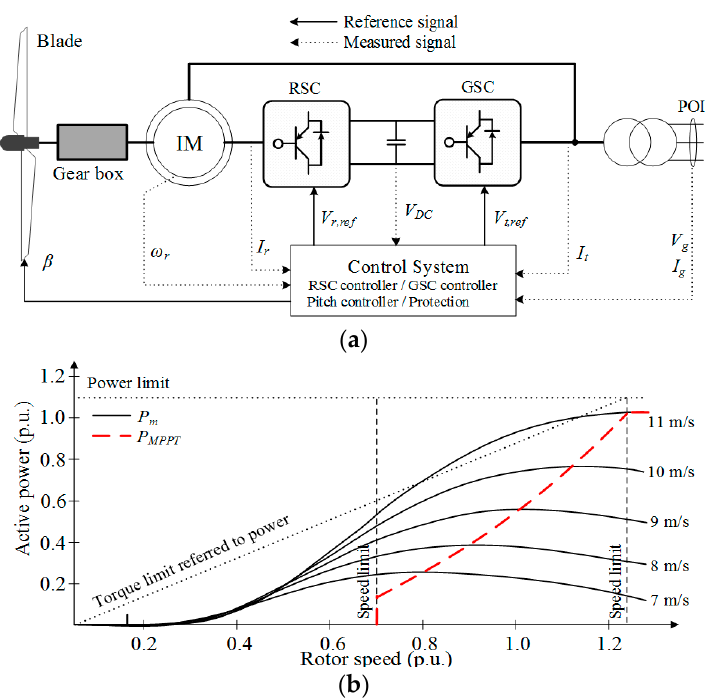
Figure 1. Typical configuration and operational characteristics of a doubly-fed induction generator (DFIG)-based wind turbine generator (WTG). ( a ) Typical configuration of a DFIG-based WTG model; ( b ) Power characteristics of a DFIG-based WTG model. I r , I t : current at rotor circuit and grid-side convertor (GSC) terminal; ω r : rotor speed; V r , ref , V t , ref : reference rotor-side convertor (RSC) and GSC voltages; V DC : DC-link voltage; V g , I g : voltage and current at the point of interconnection (POI).